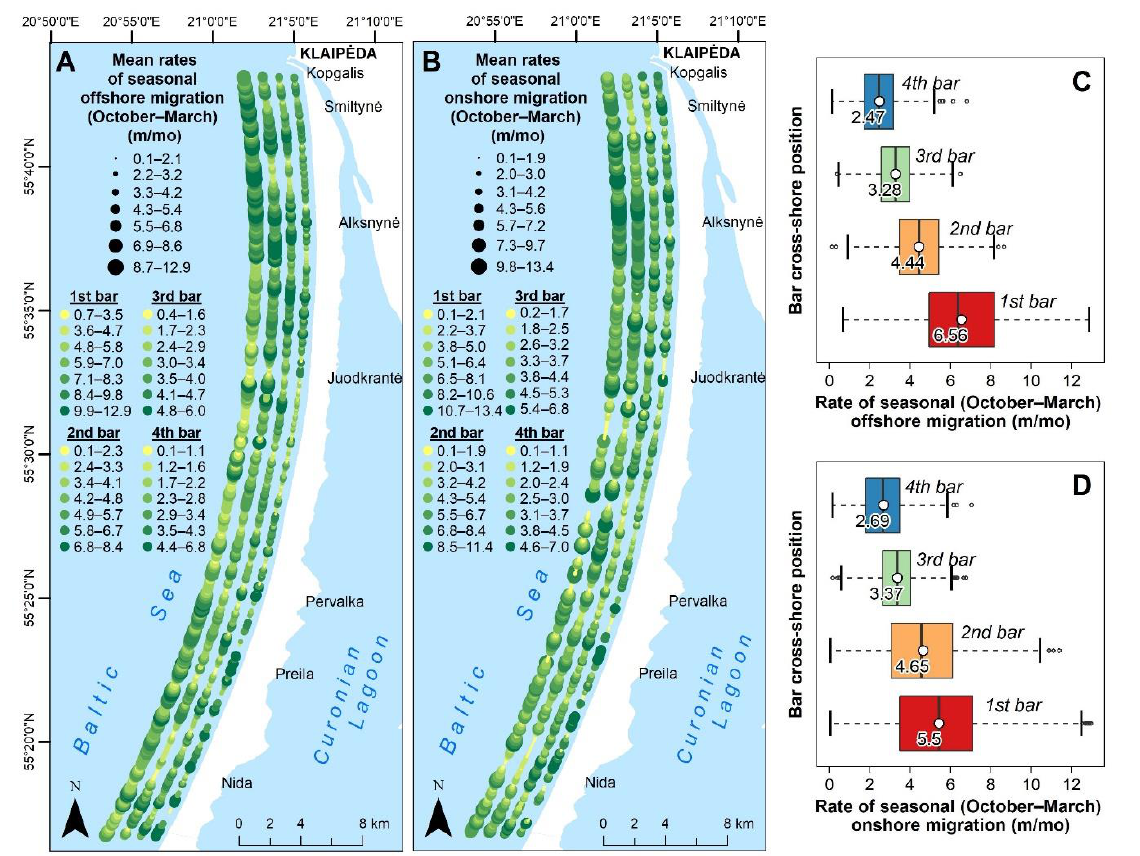
Figure 8. Alongshore variability in seasonal bar offshore ( A ) and onshore ( B ) migration rates (m/month) from October to March. The colour scale indicates mean seasonal migration rates in October − March for different bar cross-shore positions (1st to 4th bar). It is set separately for each position and explained by the legend below the underlines. The 1st bar is depicted furthest from the shore and the 4th bar − closest. Boxplots on the right illustrate the statistical distribution of the seasonal offshore ( C ) and onshore ( D ) migration rates by the cross-shore position of the bars.